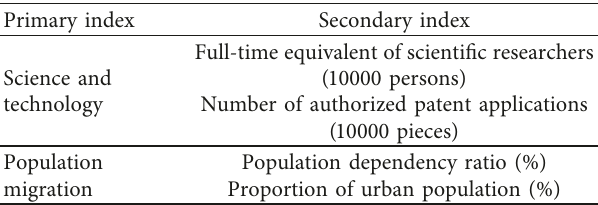
Table 1: Human capital measurement indicators.